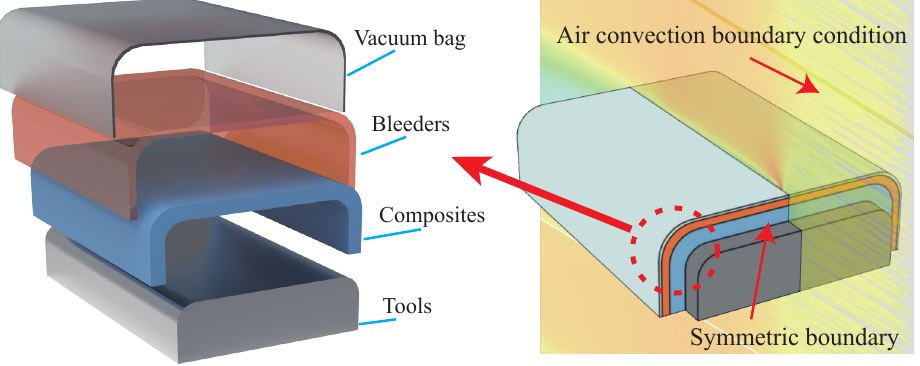
Figure 3. Temperature boundary